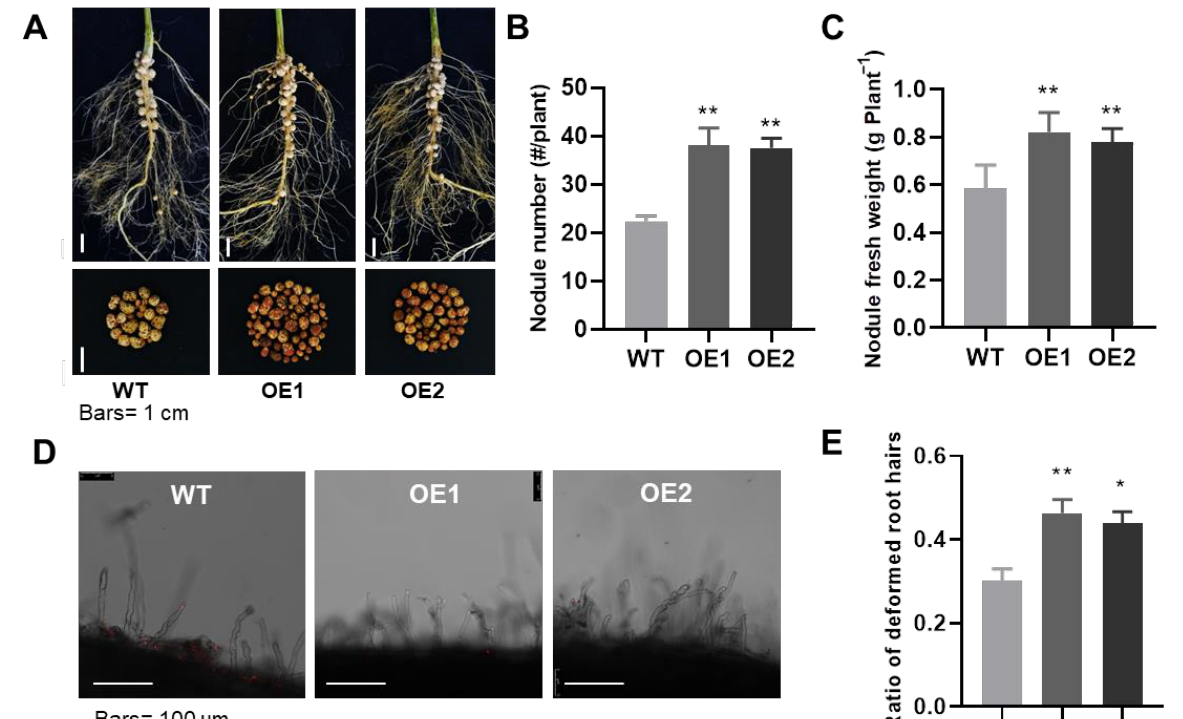
Figure 3. Overexpression of GmPHR1 promotes nodulation in soybeans. ( A ). Nodules on the roots of wild type and overexpressing transgenic (OE1 and OE2) lines of soybean seedlings. Bar = 1 cm. ( B , C ). Nodule number and nodule fresh weight of nodules in ( A ). ( D ). Observed deformed root hairs on wild type and two GmPHR1-OE lines inoculated with Bradyrhizobium elkanii BXYD3. ( E ). Comparison of deformed root hairs three days after Bradyrhizobium inoculation. For ( B , C , E ), asterisks represent statistically significantly differences from respective controls in the Student’s t test (*: 0.01 < p ≤ 0.05, **: 0.001 < p ≤ 0.01).